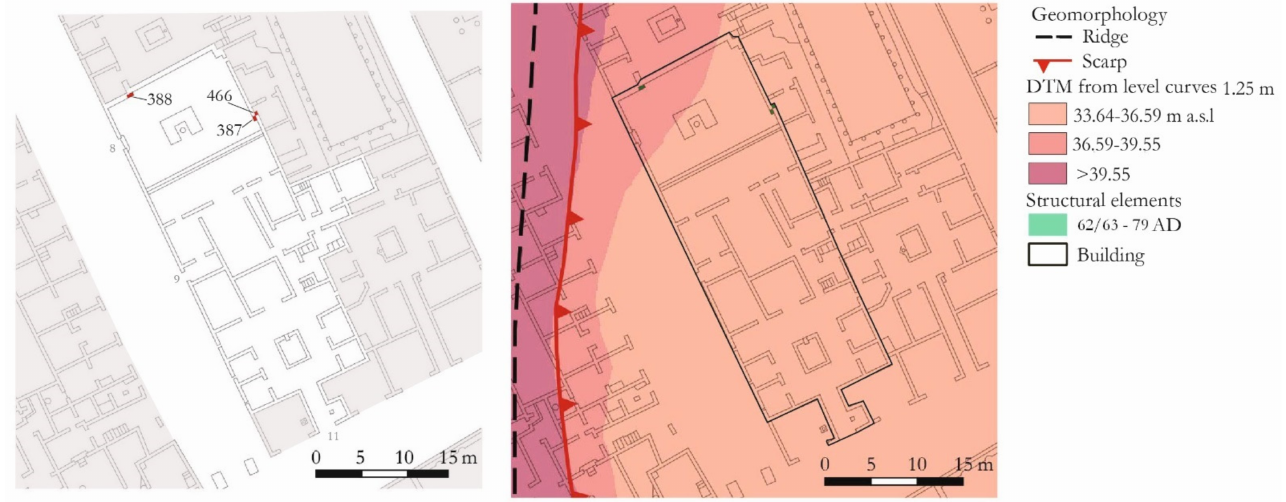
Figure 13. On the left is the plan of House of the Naviglio (VI 10, 8–10), with in red the structures built up with NYT elements. On the right the plan of the geomorphological evidence in the same area (elab. M.